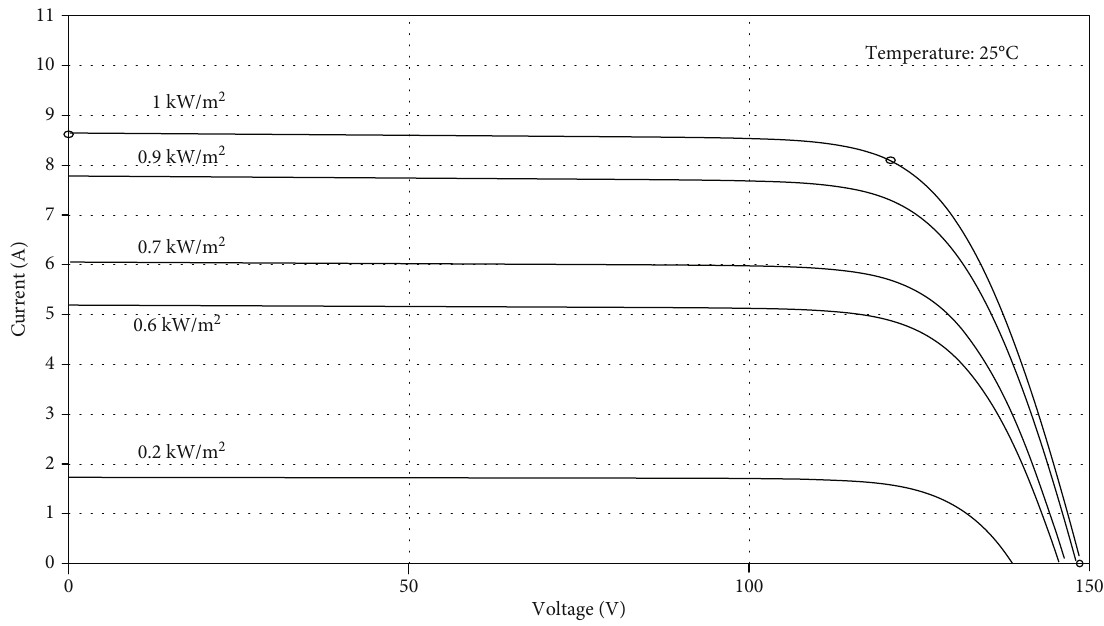
Figure 3: I-V curves of a PV array for di ff erent values of sun